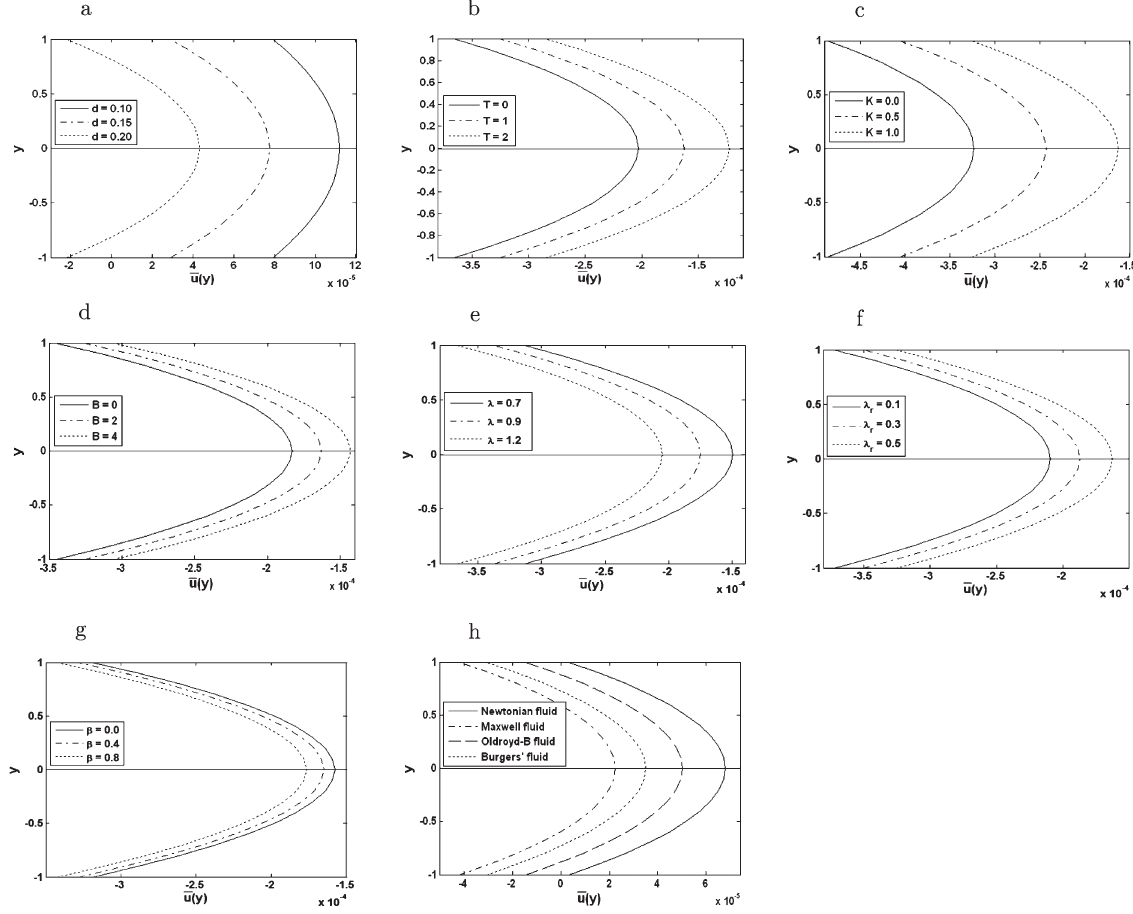
Fig. 2. The variation of mean-velocity distribution and reversal flow for three different values of wall damping d (panel( a )), wall tension T (panel( b )),springstiffness K (panel( c )),flexuralrigidity B (panel( d )),relaxationtime λ (panel( e )),retardationtime λ r (panel( f ))andBurgers’ fluid parameter β (panel( g )). The other parameters chosen are m = 0 . 01, B = 2, T = 1, K = 1, R = 10, α = 0 . 5, (cid:9) = 0 . 15, λ = 0 . 8, λ r = 0 . 5 and β = 0 . 3 (panel( a )); m = 0 . 01, B = 2, K = 1, R = 10, d = 0 . 5, α = 0 . 5, (cid:9) = 0 . 15 ,λ = 0 . 8 ,λ r = 0 . 5 and β = 0 . 3 (panel( b )); m = 0 . 01, B = 2, T = 1, d = 0 . 5, R = 10, α = 0 . 5, (cid:9) = 0 . 15, λ = 0 . 8, λ r = 0 . 5 and β = 0 . 3 (panel( c )); m = 0 . 01, d = 0 . 5, T = 1, K = 1, R = 10, α = 0 . 5, (cid:9) = 0 . 15, λ = 0 . 8, λ r = 0 . 5 and β = 0 . 3 (panel( d )); m = 0 . 01, B = 2, T = 1, K = 1, R = 10, d = 0 . 5, α = 0 . 5, (cid:9) = 0 . 15, λ r = 0 . 5 and β = 0 . 3 (panel( e )); m = 0 . 01, B = 2, T = 1, K = 1, R = 10, d = 0 . 5, α = 0 . 5, (cid:9) = 0 . 15, λ = 0 . 8 and β = 0 . 3 (panel( f )) and m = 0 . 01, B = 2, T = 1, K = 1, R = 10, d = 0 . 2, α = 0 . 5, (cid:9) = 0 . 15, λ = 0 . 8 and λ r = 0 . 5 (panel( g